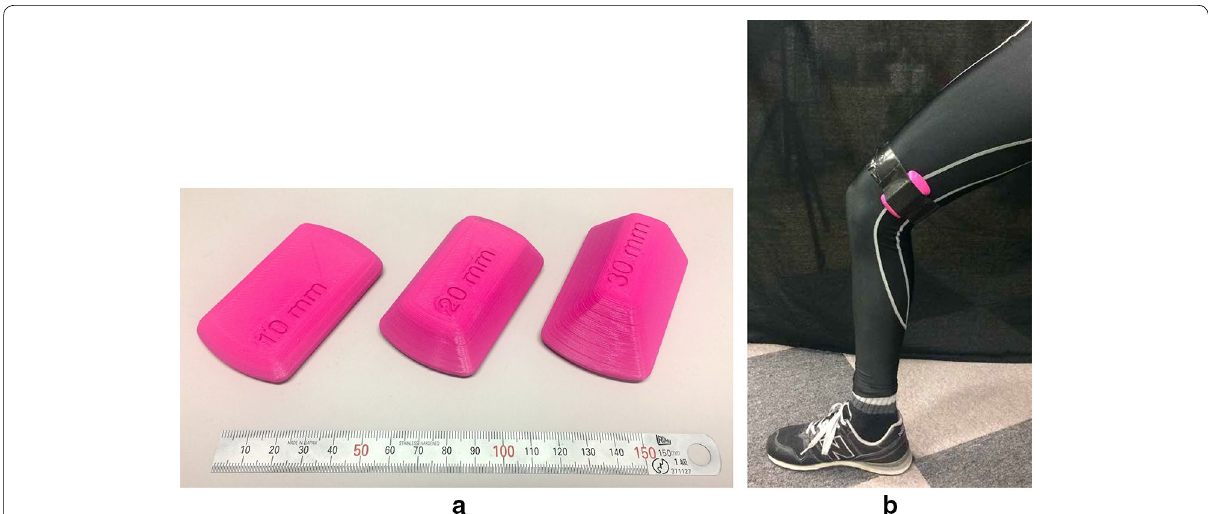
Fig. 2 Additional blocks attached to the thighs. a Additional blocks with three thickness. The thicknesses of blocks were 10 mm, 20 mm and 30 mm from left, respectively. The blocks were rounded not to harm wearers. The unit of the ruler was millimeters. b A block attached to the right thigh with tapes. The tape passed around the